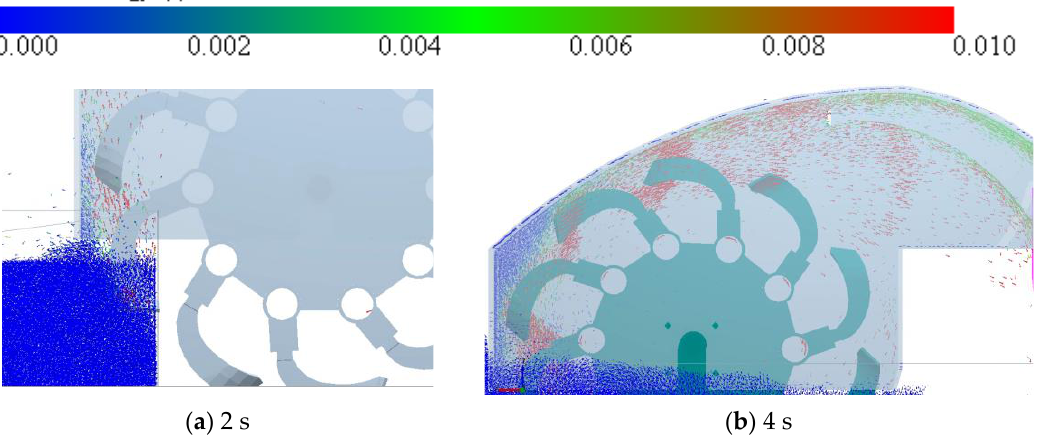
Figure 9. Soil throwing infusion process. ( a ) The soil is cut and thrown into the guide cover. ( b ) Trajectory of soil movement in the guide cover.